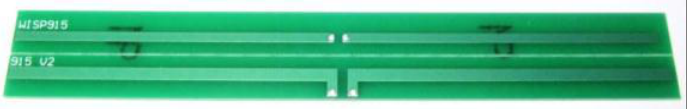
Figure 2. A 67.9 mm (L) × 5 mm (W) dipole antenna printed on FR4 board to serve as a power receiving antenna.